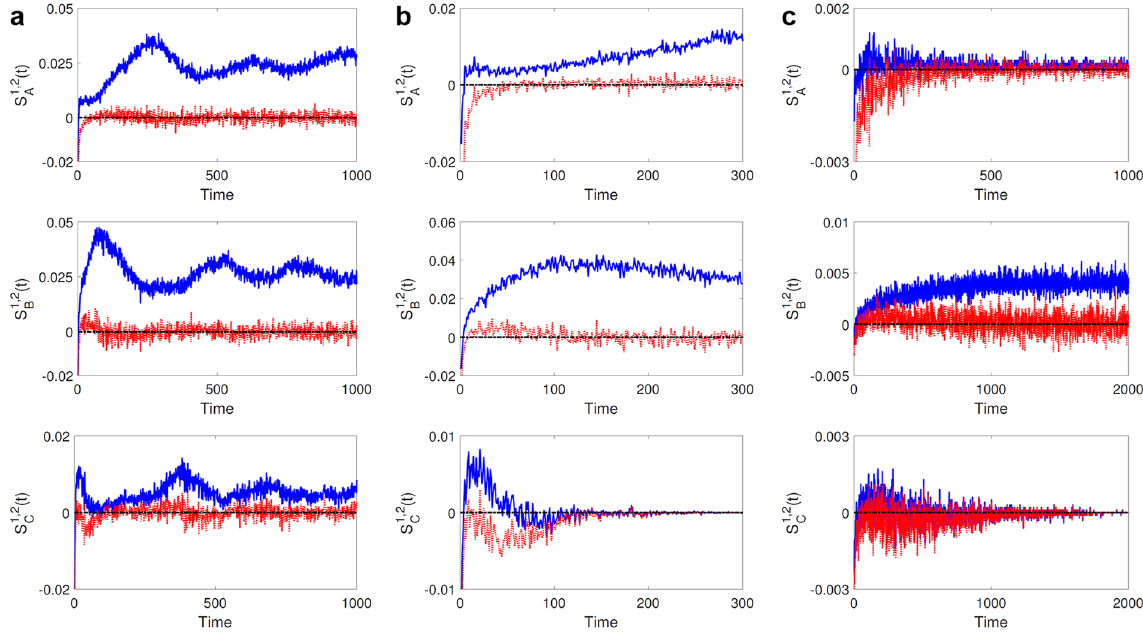
Figure 6. Qualitative indicator of effect of intraspecific competition on coexistence in RPS game. Each column shows the quantities H i (blue) and S i (red) for each species, where the corresponding coexistence states are indicated by three, two and one from left to right. ( a ) There is a gap between blue and red quantities all time. ( b ) The gap between the two quantities of a species (bottom panel) is reduced and finally disappears. The top and bottom panels of the third column in ( c ) show the collapsed gap between the two quantities.